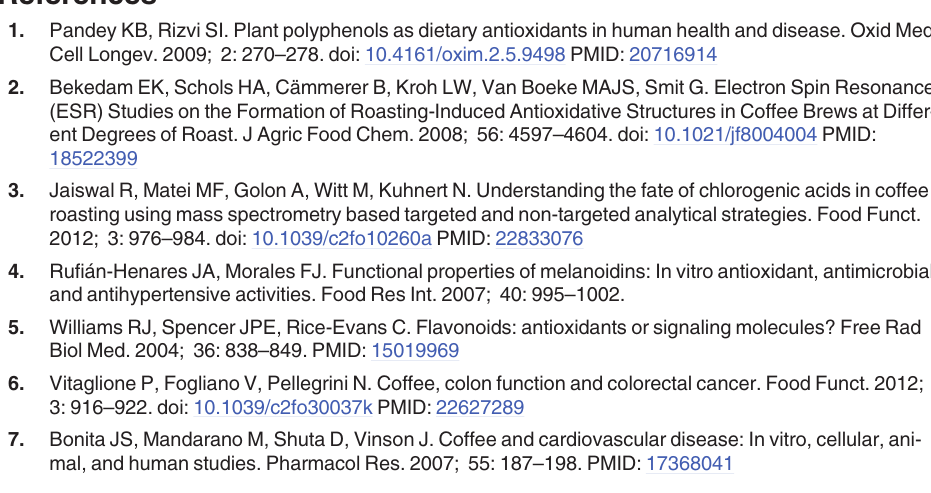
S10 Fig. Dose response curves for the reduction of DPPH (cid:129) in the presence of coffee solu- tions containing 1mM DTPA. The EC50 does not change, indicating coffee metal-polyphenol and metal-melanoidin complexes do not contribute to antiradical activity. S11 Fig. Dose response curve for the reduction of DPPH (cid:129) by Trolox in 1:1 MeOH/water. Data show the mean and SEM of 4 independent experiments. S12 Fig. Reduction of DPPH (cid:129) to its hydrazine form DPPH-H in the presence of brewed cof- fee monitored by EPR. Room-temperature CW-EPR spectra of 1:1 MeOH/water solutions containing (a) 50 μ M DPPH (cid:129) alone, or 50 μ M DPPH (cid:129) with brewed coffee diluted in water by a factor of (b) 32000, (c) 8000, (d) 4000, (e) 3000, (f) 2000, (g) 1500, (h) 1000, or (i) 500. (j) In- tensity of the DPPH (cid:129) EPR signal shown in spectra b – i , normalized to the intensity of the 50 μ M DPPH solution in spectrum a . Data represent results of a single assay performed on one brew and are therefore only qualitative. Experimental conditions: microwave frequency, 9.866 GHz; microwave power, 10 mW; magnetic field modulation amplitude, 4 G; field modulation fre- quency, 100 kHz; receiver time constant, 82 ms; receiver gain, 70 dB; sweep rate, 4 G/s; aver-